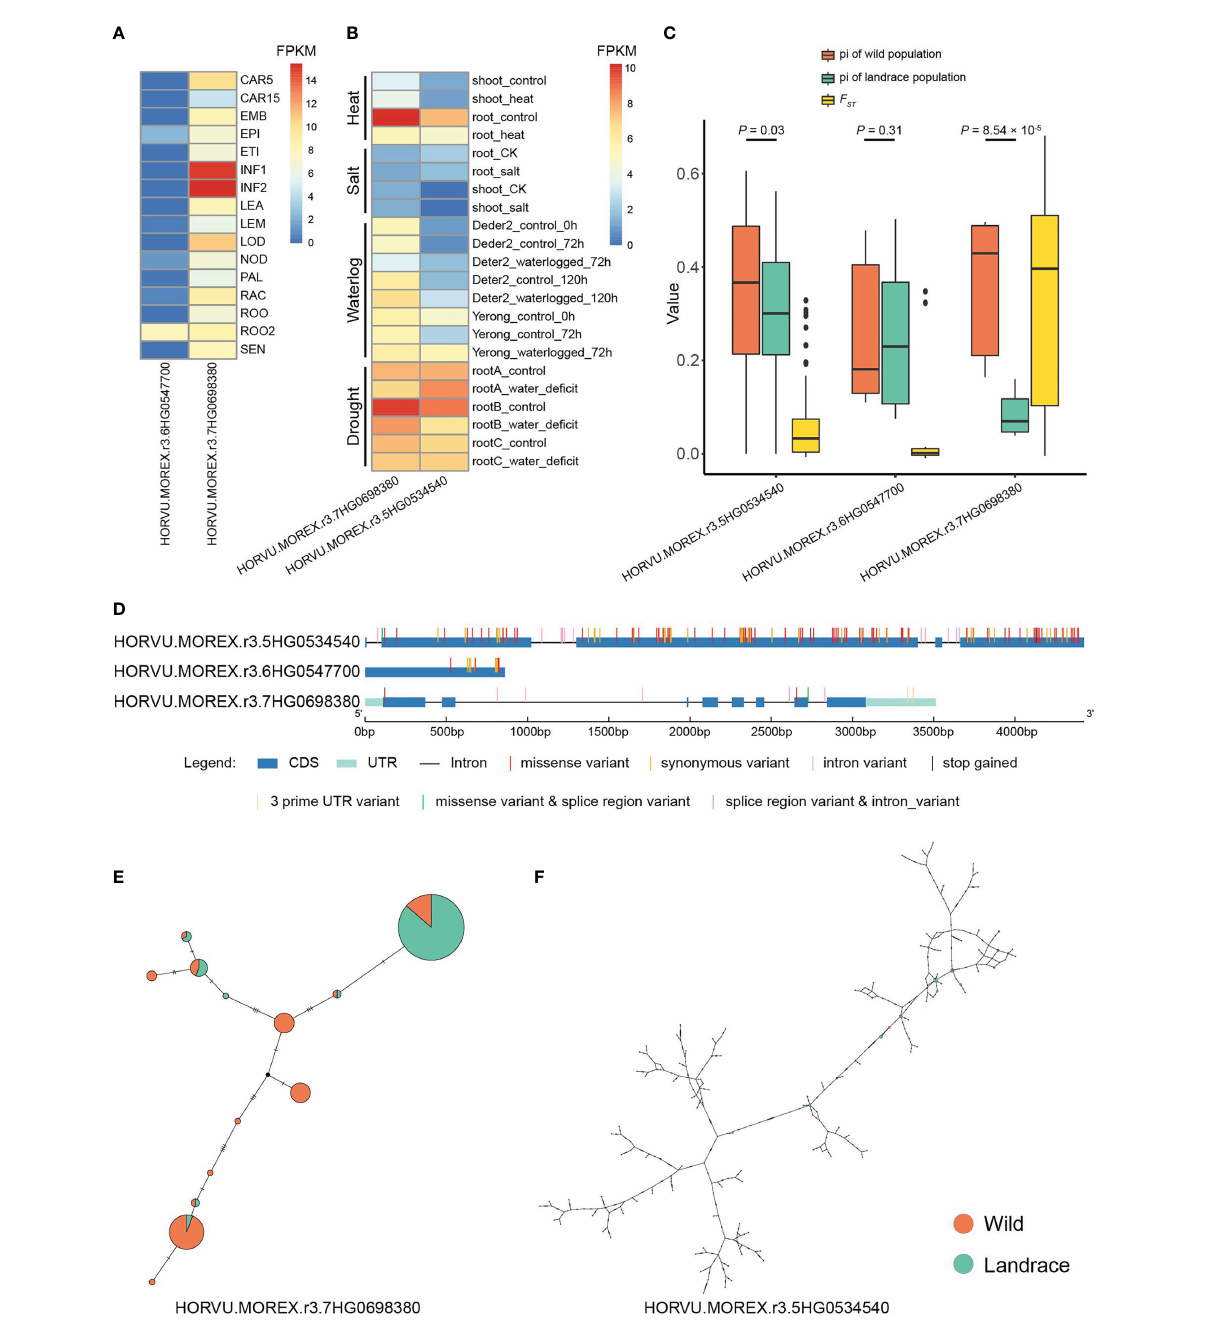
FIGURE 9 Expression pattern and median-joining haplotype networks of TF-type expanded genes. (A) Expression pattern of candidate genes in different tissues/stages. CAR15, bracts removed grains at 15DPA; CAR5, bracts removed grains at 5DPA; EMB, embryos dissected from 4-day-old germinating grains; EPI, epidermis with 4 weeks old; ETI, etiolated from 10-day-old seedling; INF1, young in fl orescences with 5 mm; INF2, young in fl orescences with 1 – 1.5 cm; LEA, shoot with the size of 10 cm from the seedlings; LEM, lemma with 6 weeks after anthesis; LOD, lodicule with 6 weeks after anthesis; NOD, developing tillers at six-leaf stage; PAL, in fl orescences, palea (6 weeks after pollination); RAC, in fl orescences, rachis (5 weeks after pollination); ROO, roots from the seedlings with 17 and 28 days old after planting; ROO2, roots (4 weeks after pollination); SEN, senescing leaf. (B) Expression pattern of candidate genes under different stresses. (C) The boxplots of pi and FST values for candidate genes. (D) Distribution of nucleotide variants within the candidate genes. (E, F) Median-Joining haplotype networks of candidate genes in wild barley and landrace populations. The circle size represents the number of accessions holding a particular haplotype. The orange and green circles refer to wild barley and landrace accessions,